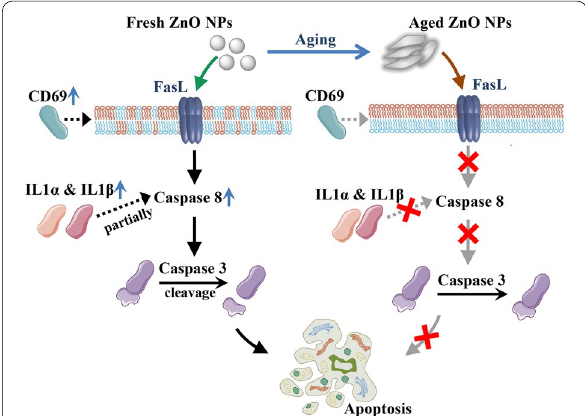
Fig. 7 Model for Fresh ZnO NPs but not aged ZnO NPs induces Caspase 8- and Caspase 3-dependent apoptosis. The increased expression of apoptotic gene CD69 activates Fas and apoptosis annexin V expression in fresh ZnO NP-exposed mammalian cells. The increased expression of apoptotic gene IL1α and IL1β partially activates Caspase 8-dependent apoptosis. It further causes activation of Caspase 3 and induces apoptosis. All these changes in mRNA and protein level were not detectable in aged ZnO NPs-exposed mammalian